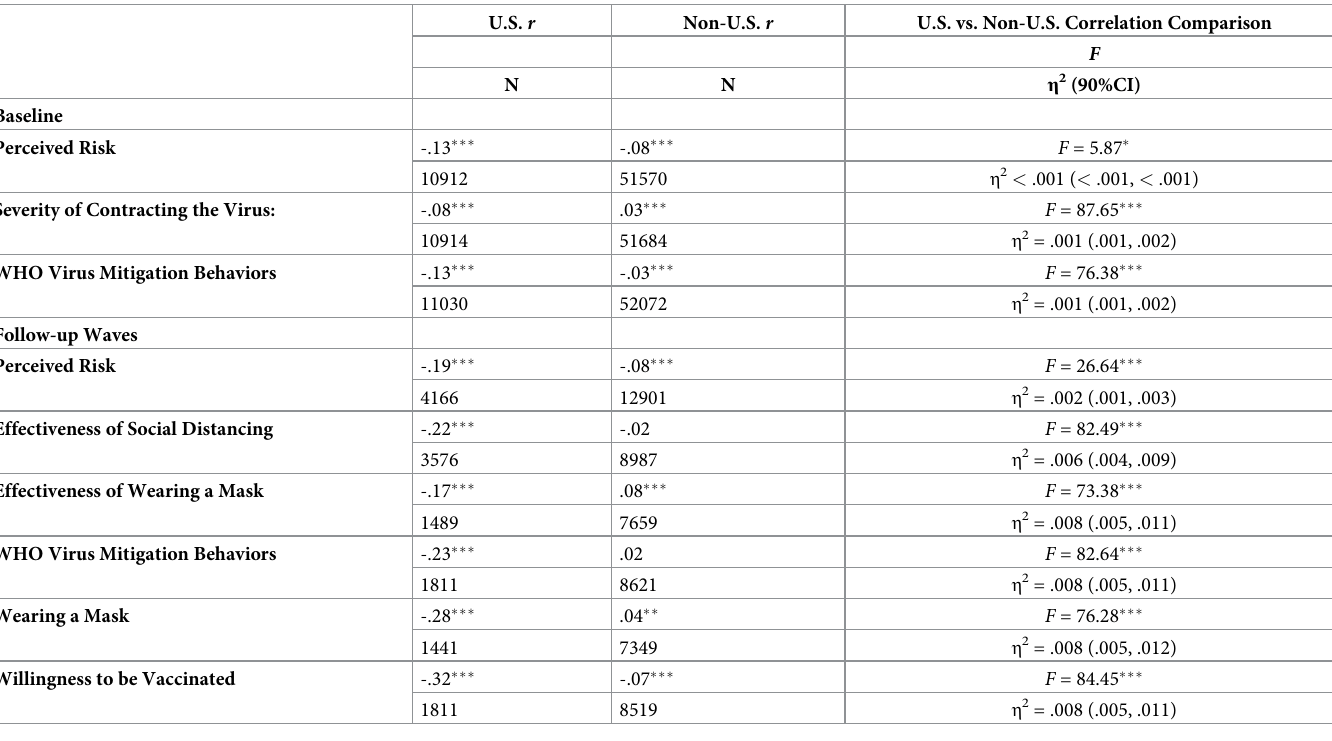
Table 5. Correlations between baseline political orientation and perceived risk, perceived effectiveness, and health-protective behaviors, Study 2. U.S.